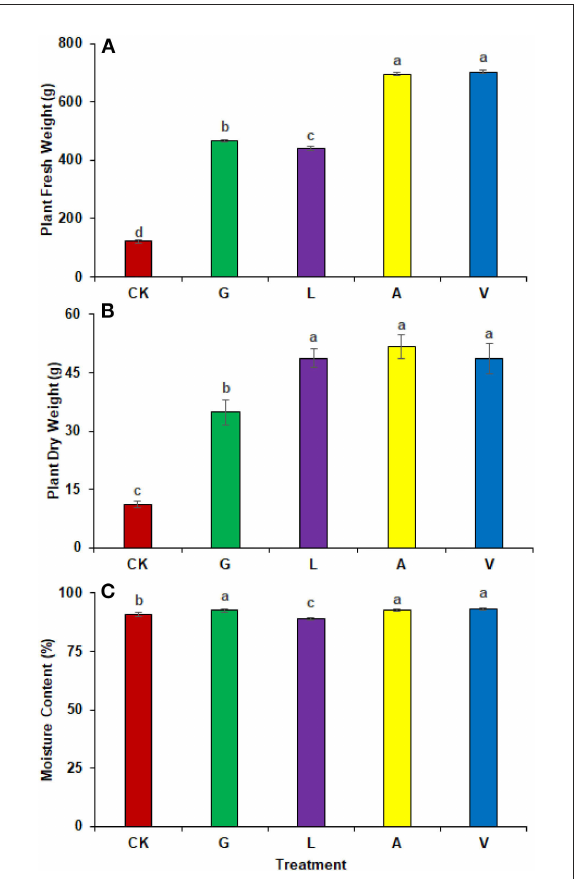
FIGURE1 Pigment analysis: (A) Photosynthetic pigments (B) Leaf greenness indexes observed in experiment 1 using chemical fertilizer (CK), glycine (G), lysine (L), aspartic acid (A), and vitamin B complex (V). The values mentioned herein are indicated as mean ± S.D and the lowercase letters indicate the significant difference among the means.